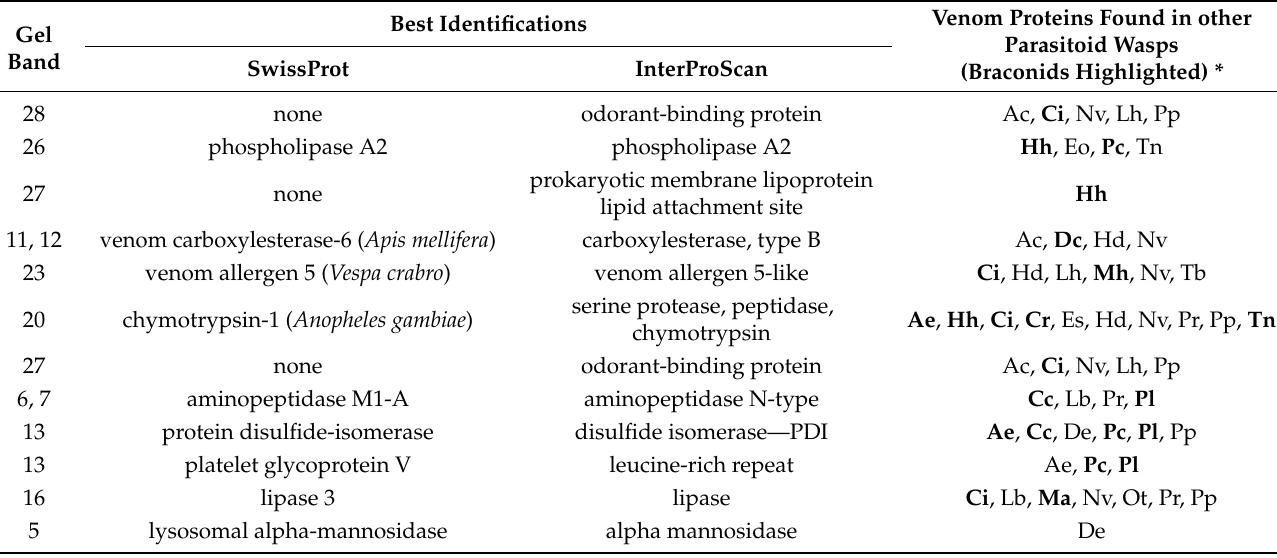
Table 5. Putative identifications of venom proteins of H. nigricans based of reference to the SwissProt database (https: //www.uniprot.org) and InterProScan (https://www.ebi.ac.uk/interpro/) which classifies proteins into functional families. In addition, proteins located in bands 7, 9, 10, 11 showed no similarity to anything on SwissProt and were indicated as protein domain family DUF4803 by InterProScan. Braconidae matches are in bold. (Source: based on Table 2 [51]).